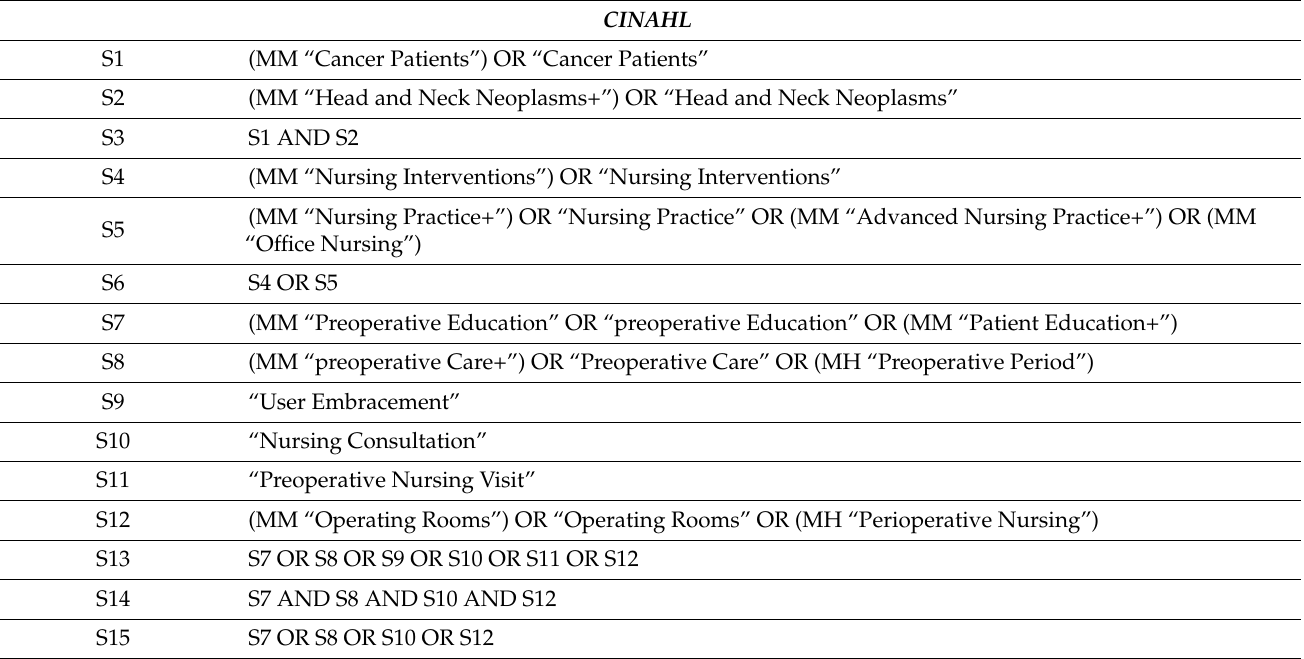
Table 3. Syntaxes of combined descriptors in the scientific database